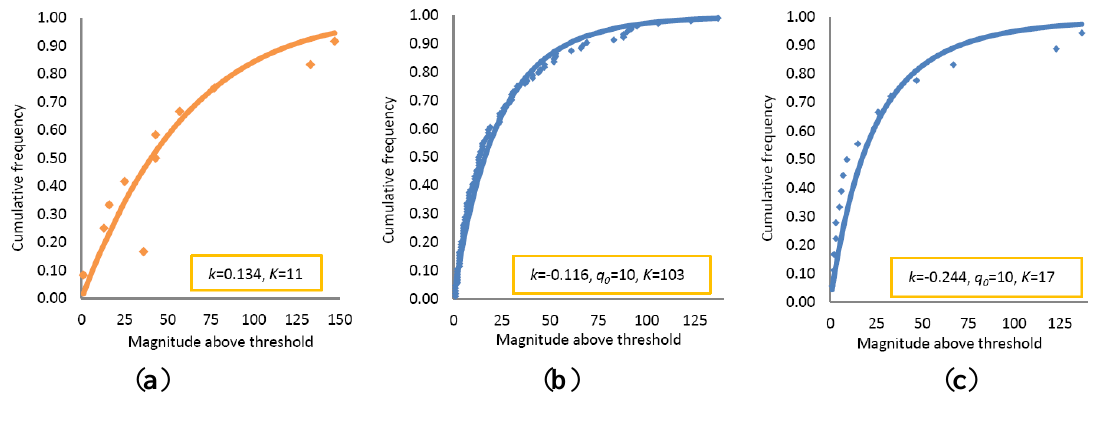
Figure 5. Cumulative distribution functions (CDFs) of observed magnitudes over the 80th percentile level based on three definitions in Duval County. ( a ) Traditional